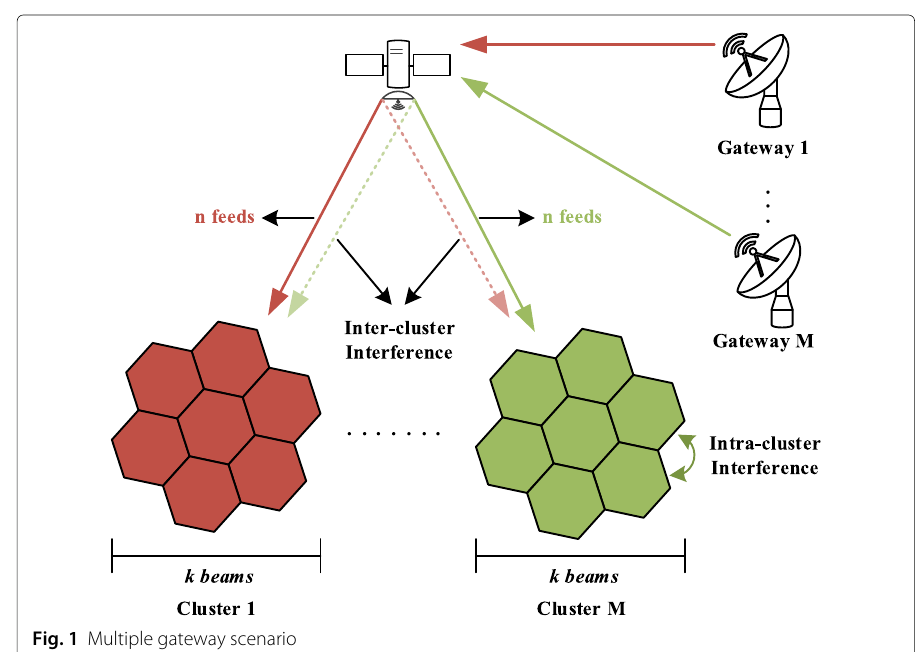
Fig. 1 Multiple gateway scenario